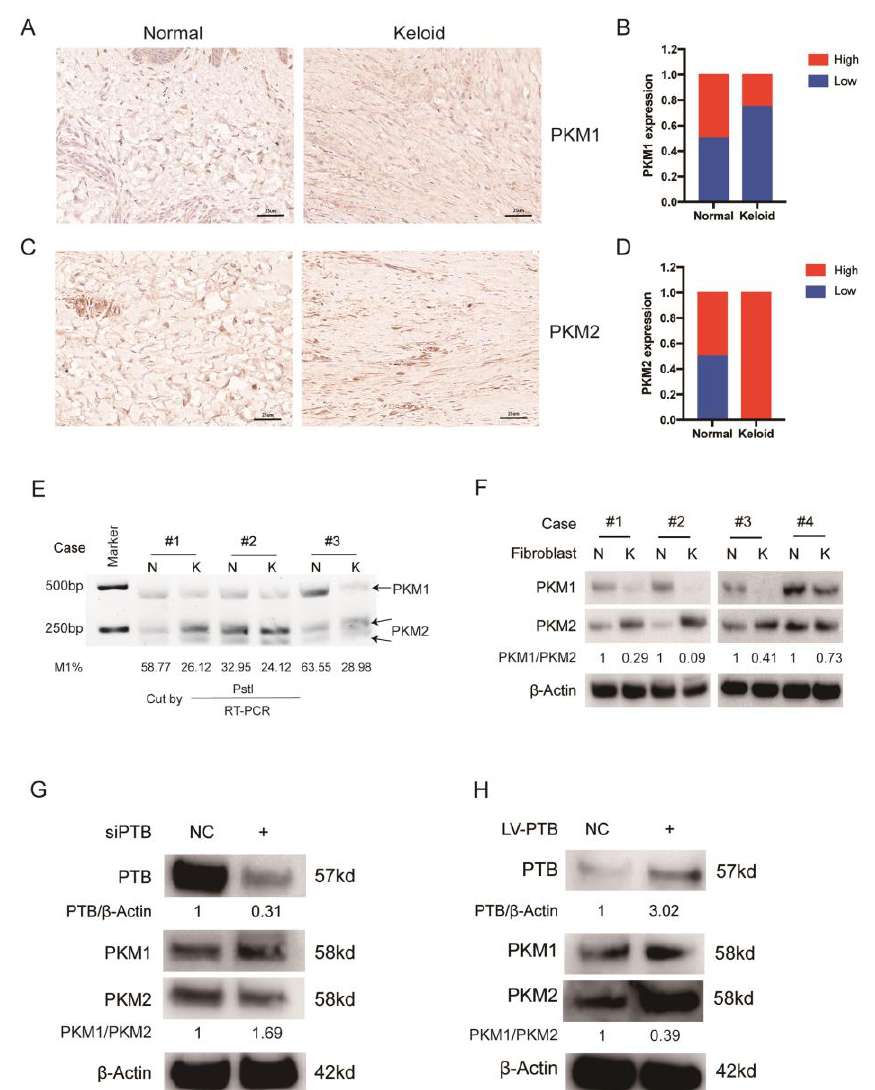
Figure 4. PTB regulates PKM2 splicing in KFb. ( A ) The expression of PKM1 was detected in keloid tissues and the corresponding normal skin tissues by IHC. ( B ) Differences in the expression scores of PKM1 between keloid tissues and the corresponding normal tissues are presented as a histogram ( n = 4). ( C ) The expression of PKM2 was detected in keloid tissues and the adjacent normal skin tissues by IHC. ( D ) Differences in PKM2 expression scores between keloid tissues and the corresponding normal tissues are presented as a histogram ( n = 4). ( E ) The PKM1 and PKM2 isoforms were detected using PstI and RT-PCR in the NFb ( n = 3) and KFb ( n = 3). ( F ) PKM1 and PKM2 protein levels in the KFb ( n = 4) and the matched adjacent NFb ( n = 4) were detected by Western blotting. ( G ) PTB silencing reduced the protein levels of PKM2 in KFb detected by Western blotting. ( H ) PTB overexpression in NFb increased the protein levels of PKM2. Data are presented as the mean ± S.D.